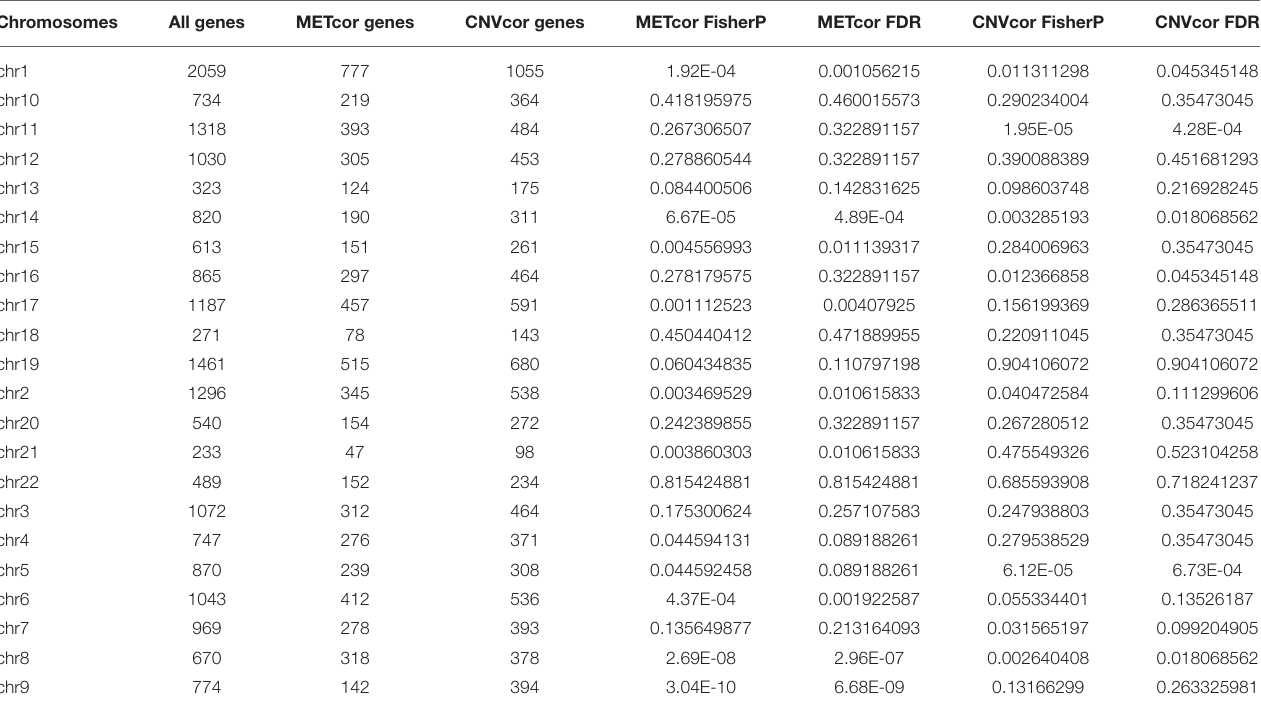
TABLE 2 | Fisher significance test of CNVCor and METCor gene frequencies on